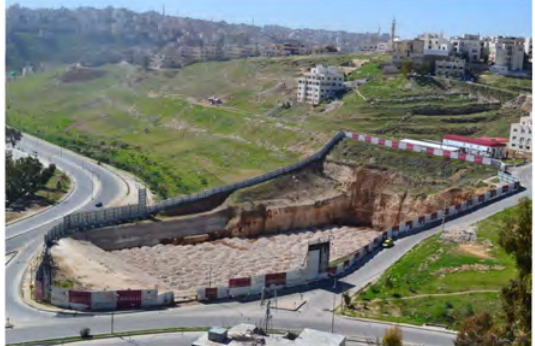
Figure 18. Sanaya Amman (Limitless towers) hole post filling it with sand and gravel. Source: Project: Manifesto, Holes on hold competition (2011)